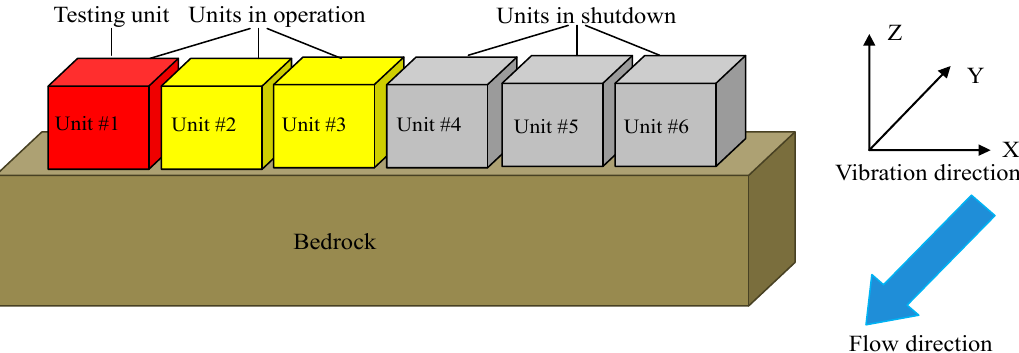
Figure 6. Distribution of units in the main powerhouse and definition of vibration directions.